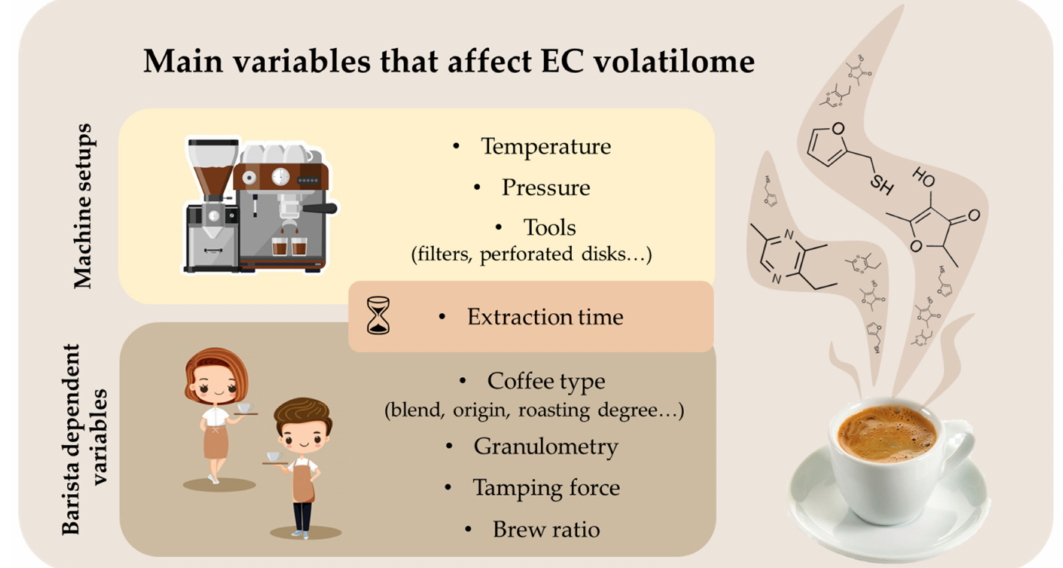
Figure 1. Main preparation variables that influence the EC